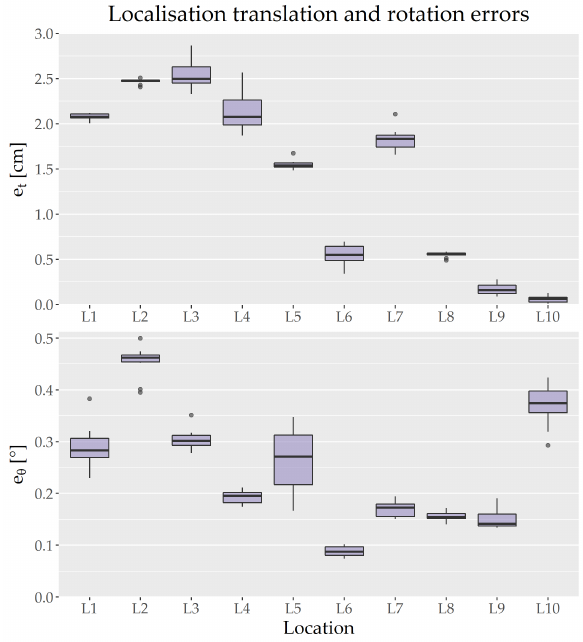
Figure 5. Localisation simulation